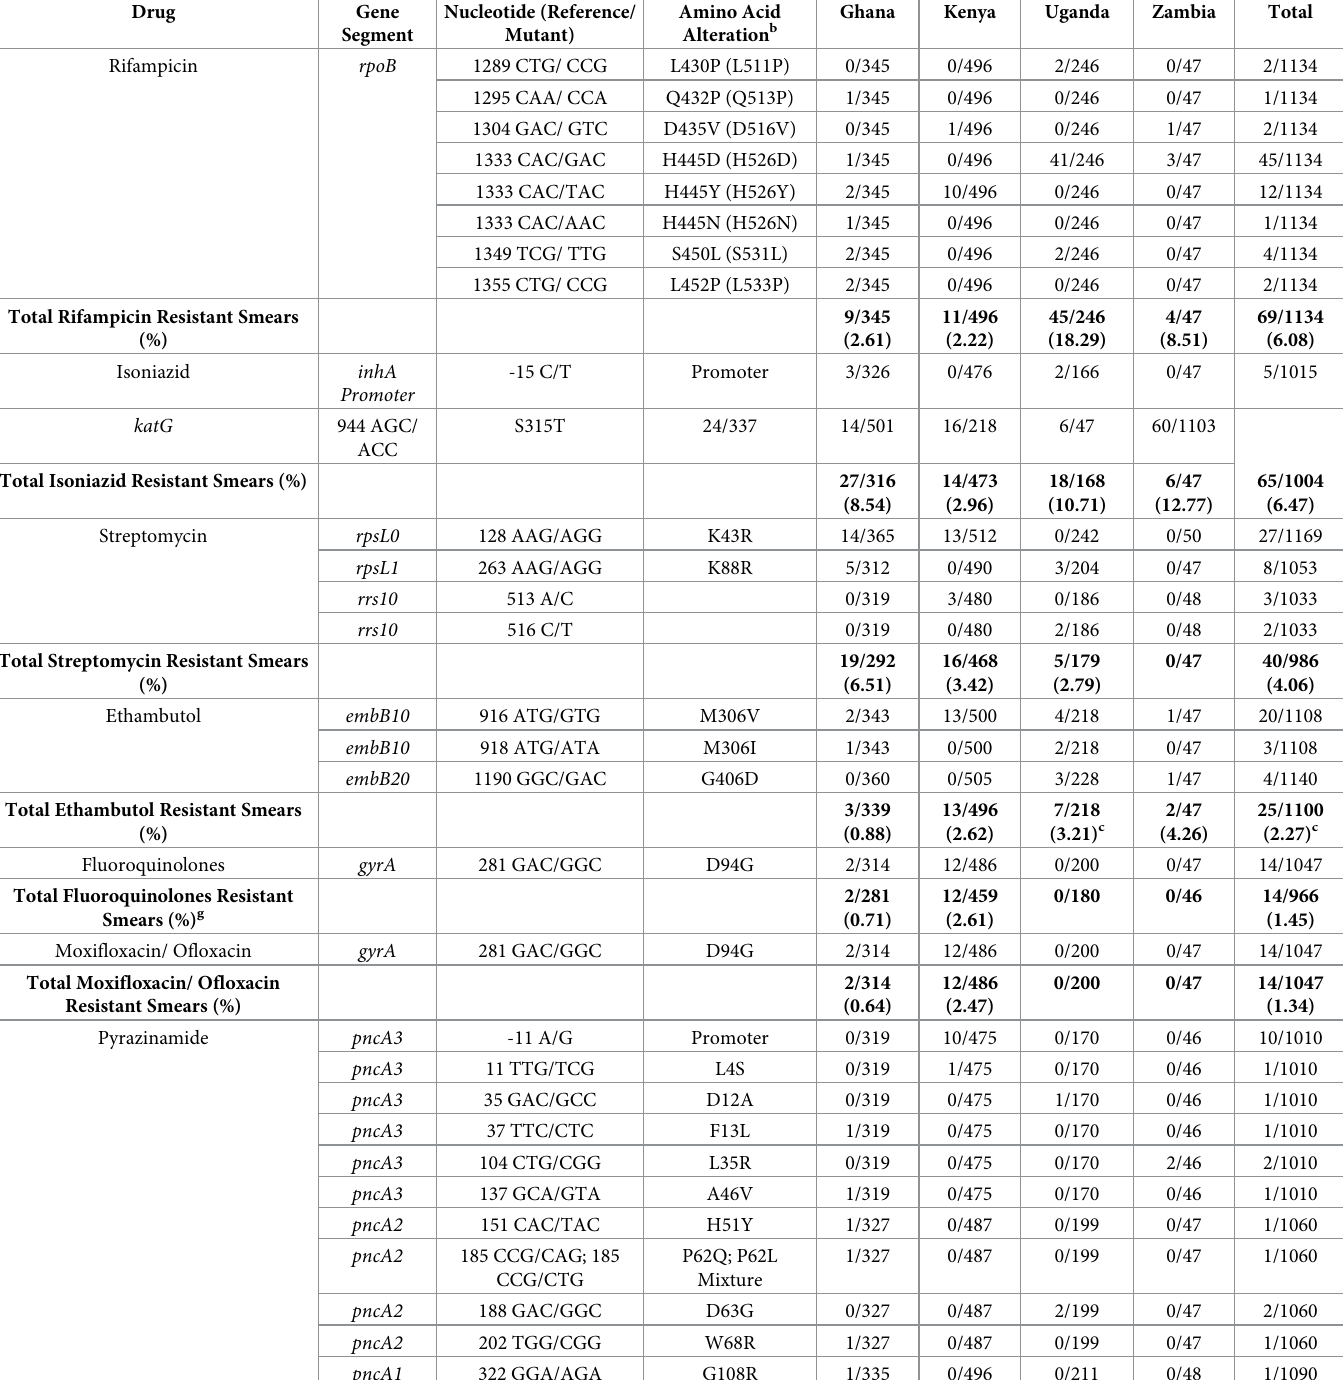
Table 3. Summary of drug resistance associated mutations detected in direct AFB smears and total number of drug resistant smears from Ghana, Kenya, Uganda, and Zambia, by drug type a .